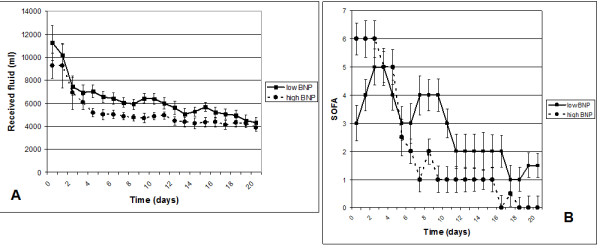
Total received fluid and SOFA scores in patients with high and low BNP. A. Received fluid, B. Sequential Organ Failure Assessment (SOFA) scores. Dashed line presents patients with a high B-type Natriuretic Peptide (BNP), closed line patients with a low BNP.